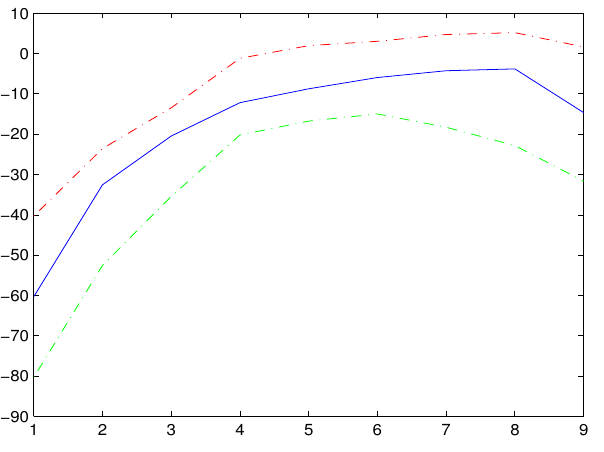
Figure 5. ˆ m ( z ) and its 95% confidence intervals for the dataset of Indonesian rice farming in